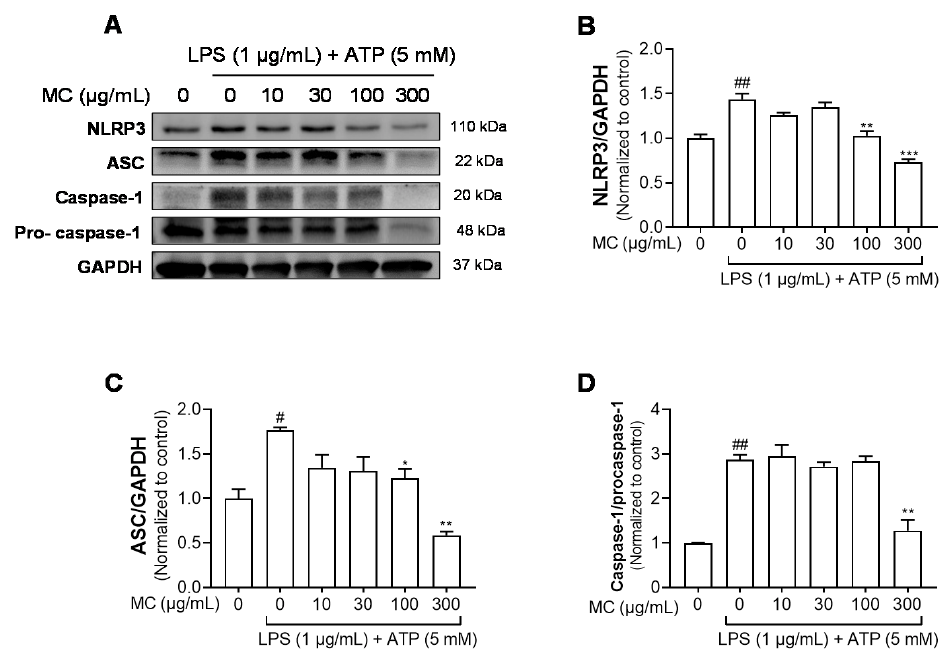
Figure 4. Effects of M. concanensis on the NLRP3 inflammasome activation in HaCaT keratinocytes. Cells were pretreated with M. concanensis (MC) for 1 h before LPS stimulation (1 µ g/mL) for 24 h and ATP (5 mM) for 1 h. The protein expressions of NLRP3, ASC and Caspase-1 in HaCaT cells were determined by immunoblot analysis ( A – D ). The data presented are the mean of three independent determinations and indicate the mean ± S.E.M. # p < 0.05 and ## p < 0.01 compared to the vehicle-treated controls; * p < 0.05, ** p < 0.01 and *** p < 0.001 compared to the LPS-treated group.